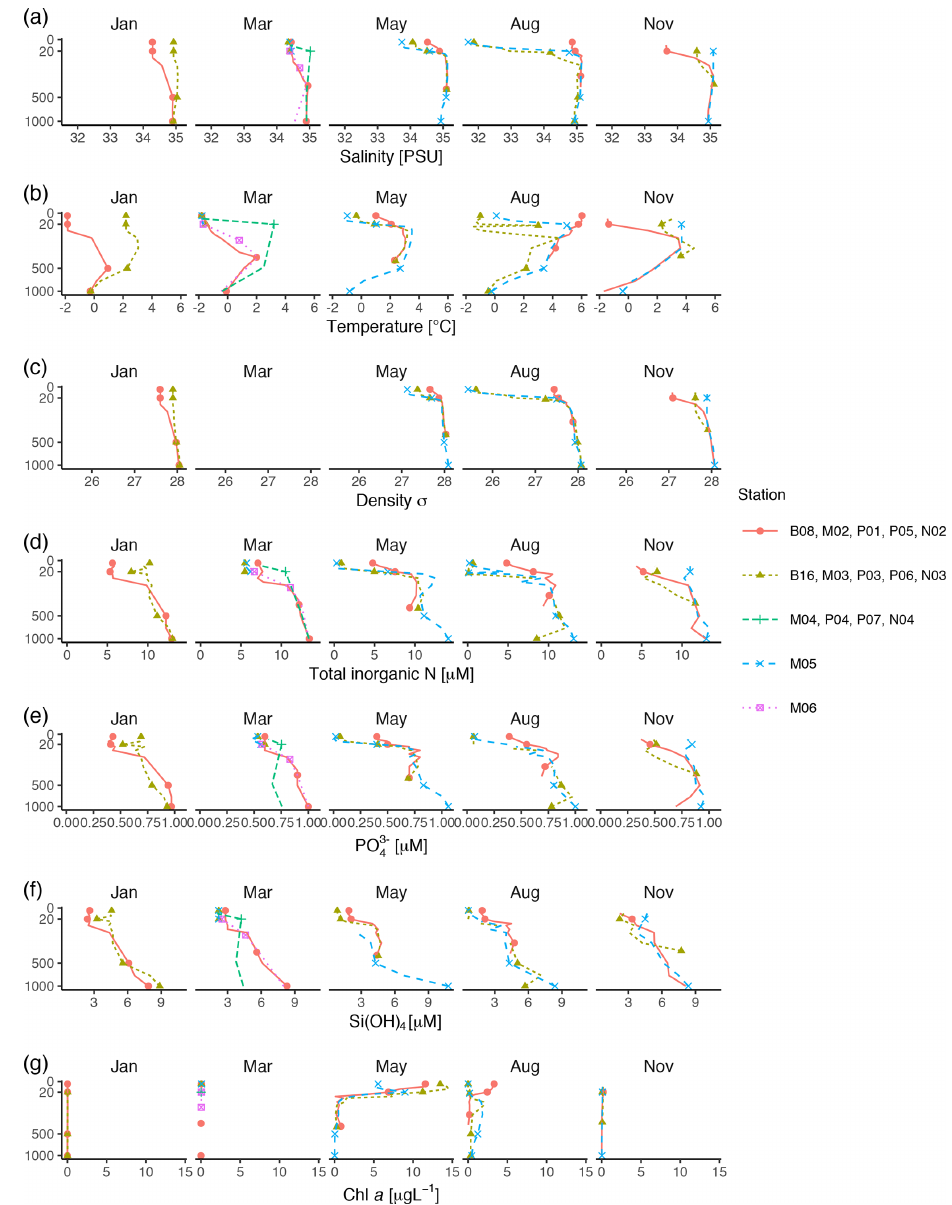
Figure 2. Profiles of environmental variables measured during the MicroPolar cruises. (a) Salinity [PSU], (b) temperature [ ◦ C], (c) density [kgm − 3 ], (d) total inorganic N [µM], (e) PO 3 − [µM] (f) Si(OH) 4 [µM], and (g) chl a [µgL − 1 ]. Data obtained from Paulsen et al. (2017). 4 Points indicate the depths where samples for protist metabarcoding were taken with Niskin bottles. To better distinguish between data points in the epipelagic zone, the y axis is square-root-transformed. The full profile was not available from all